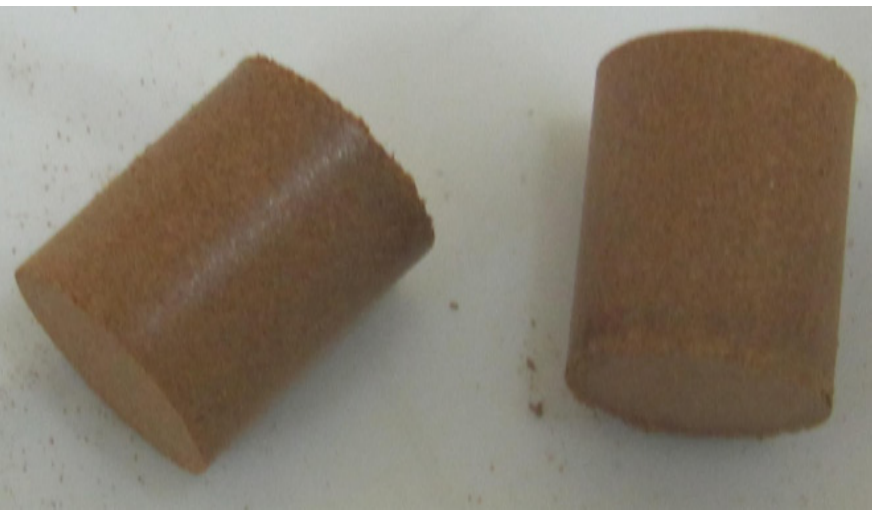
Figure 1. Densified sawdust pellets.